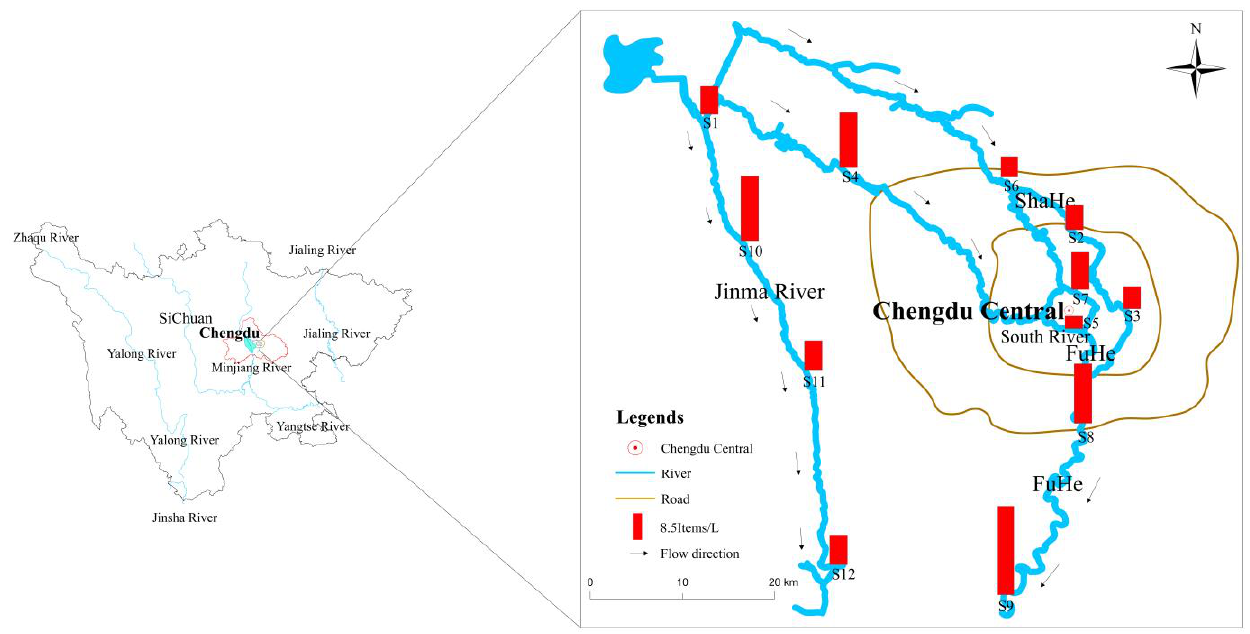
Figure 1. The geographic positions of the sample sites and the distribution of cities.